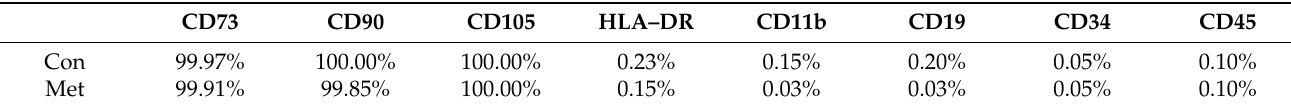
Table 1. Percentage of cells expressing